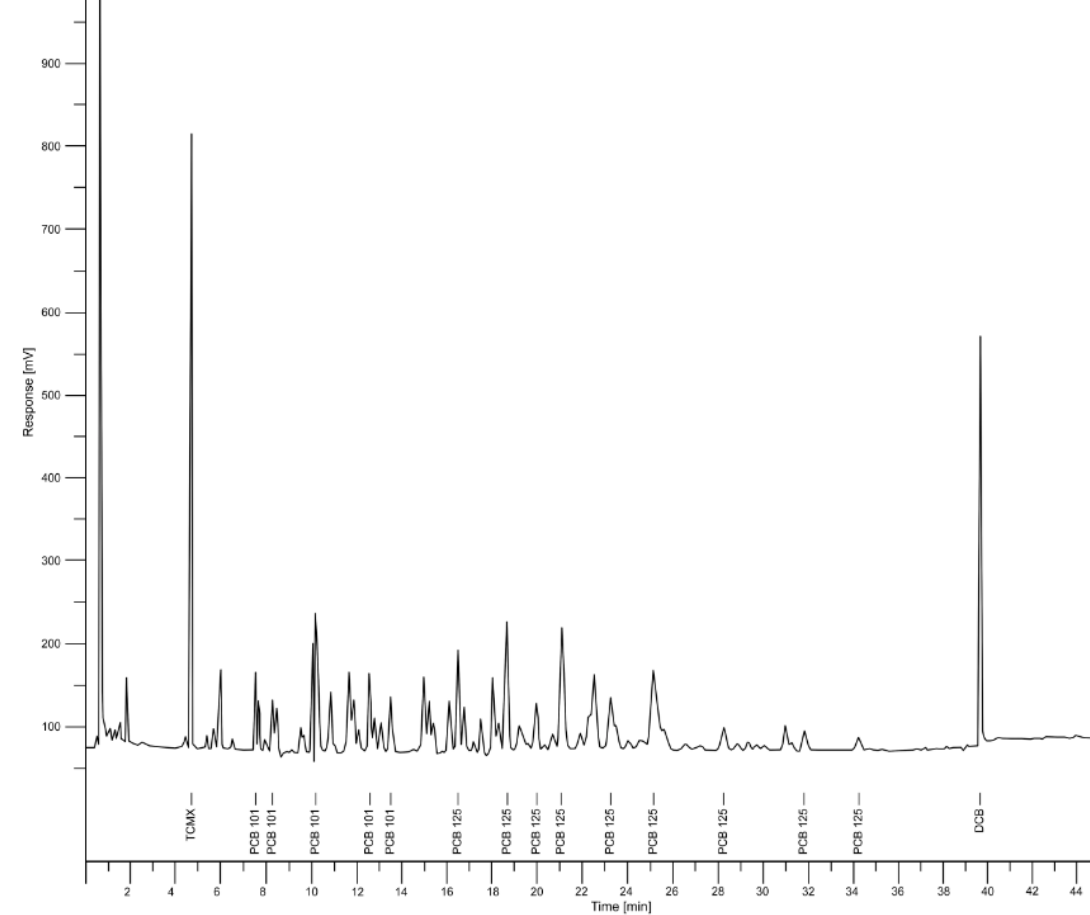
Figure 4. GC-ECD chromatogram of caulk sample extract (WG-10) from school number 1, showing PCB peaks and the elution times.